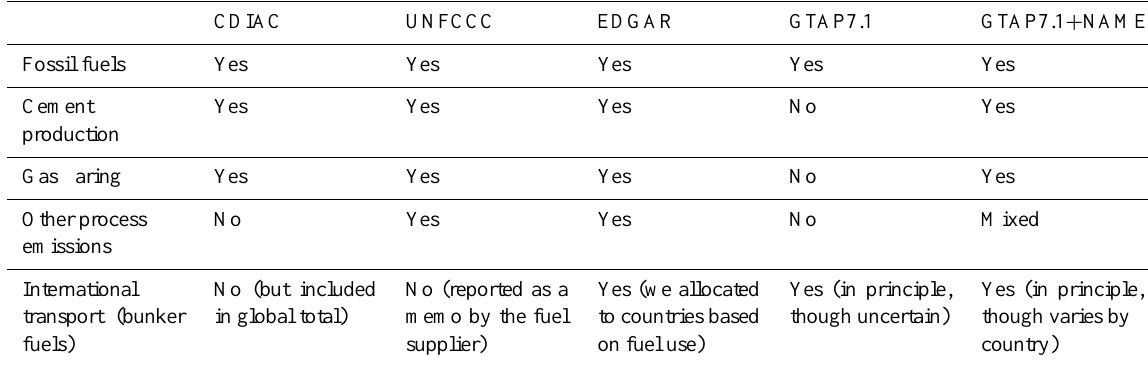
Table 2. The key features included in the different carbon emission datasets used in this study.